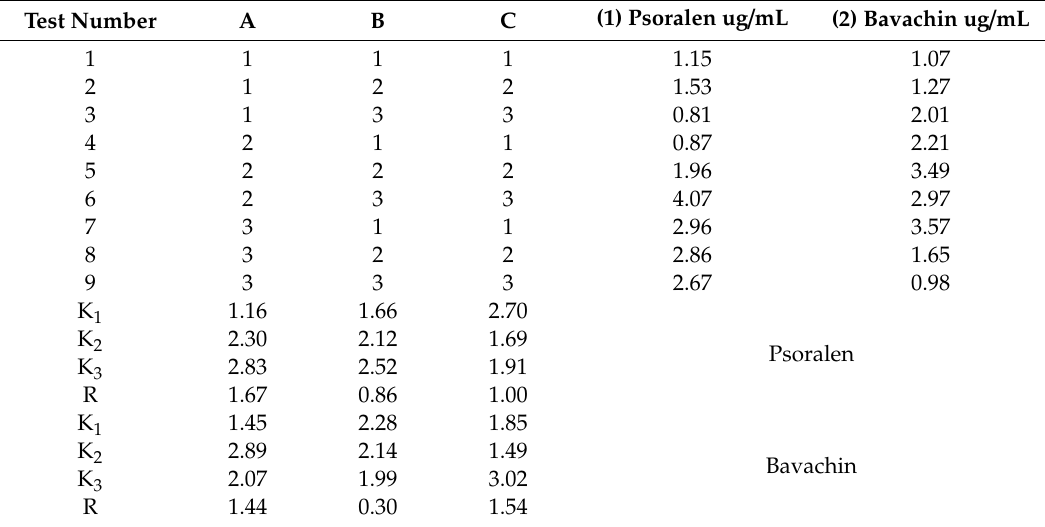
Table 2. L 9 (3 3 ) orthogonal test design and UV determination results ( n = 3).